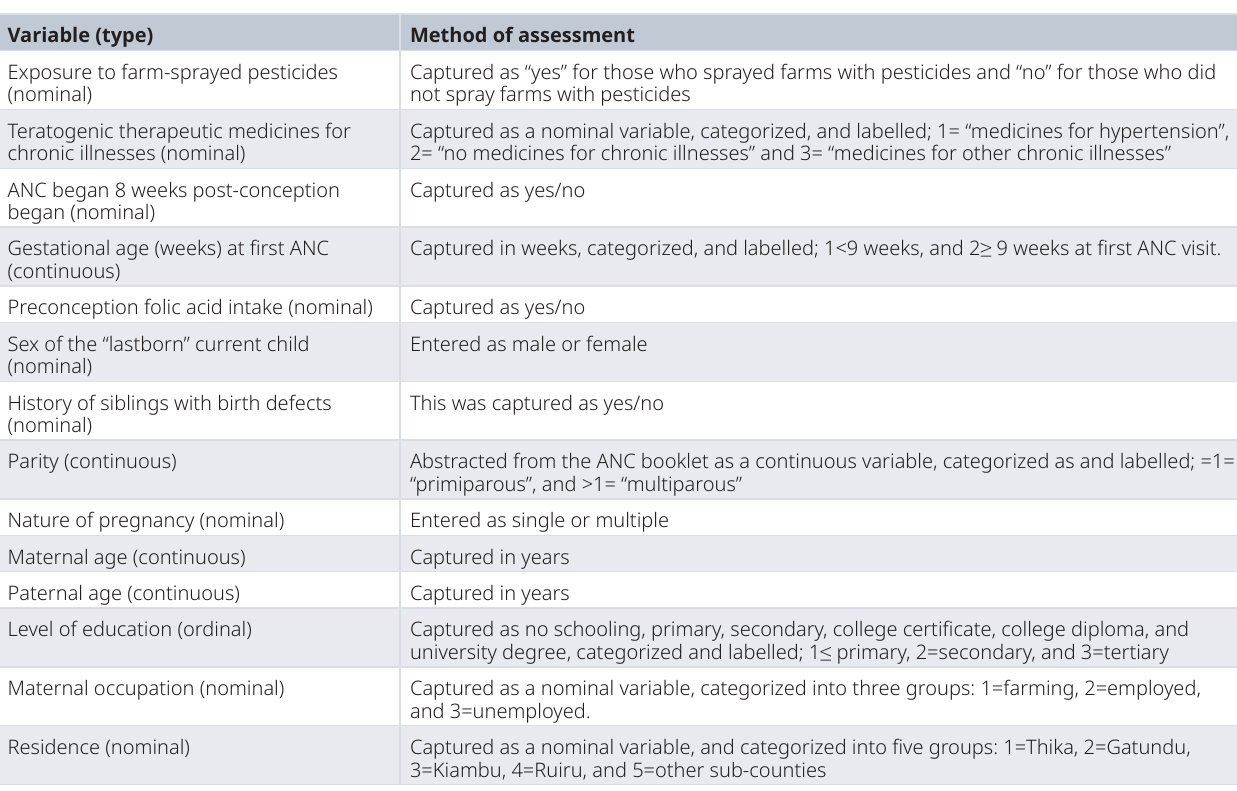
Table 1. Study variables and their